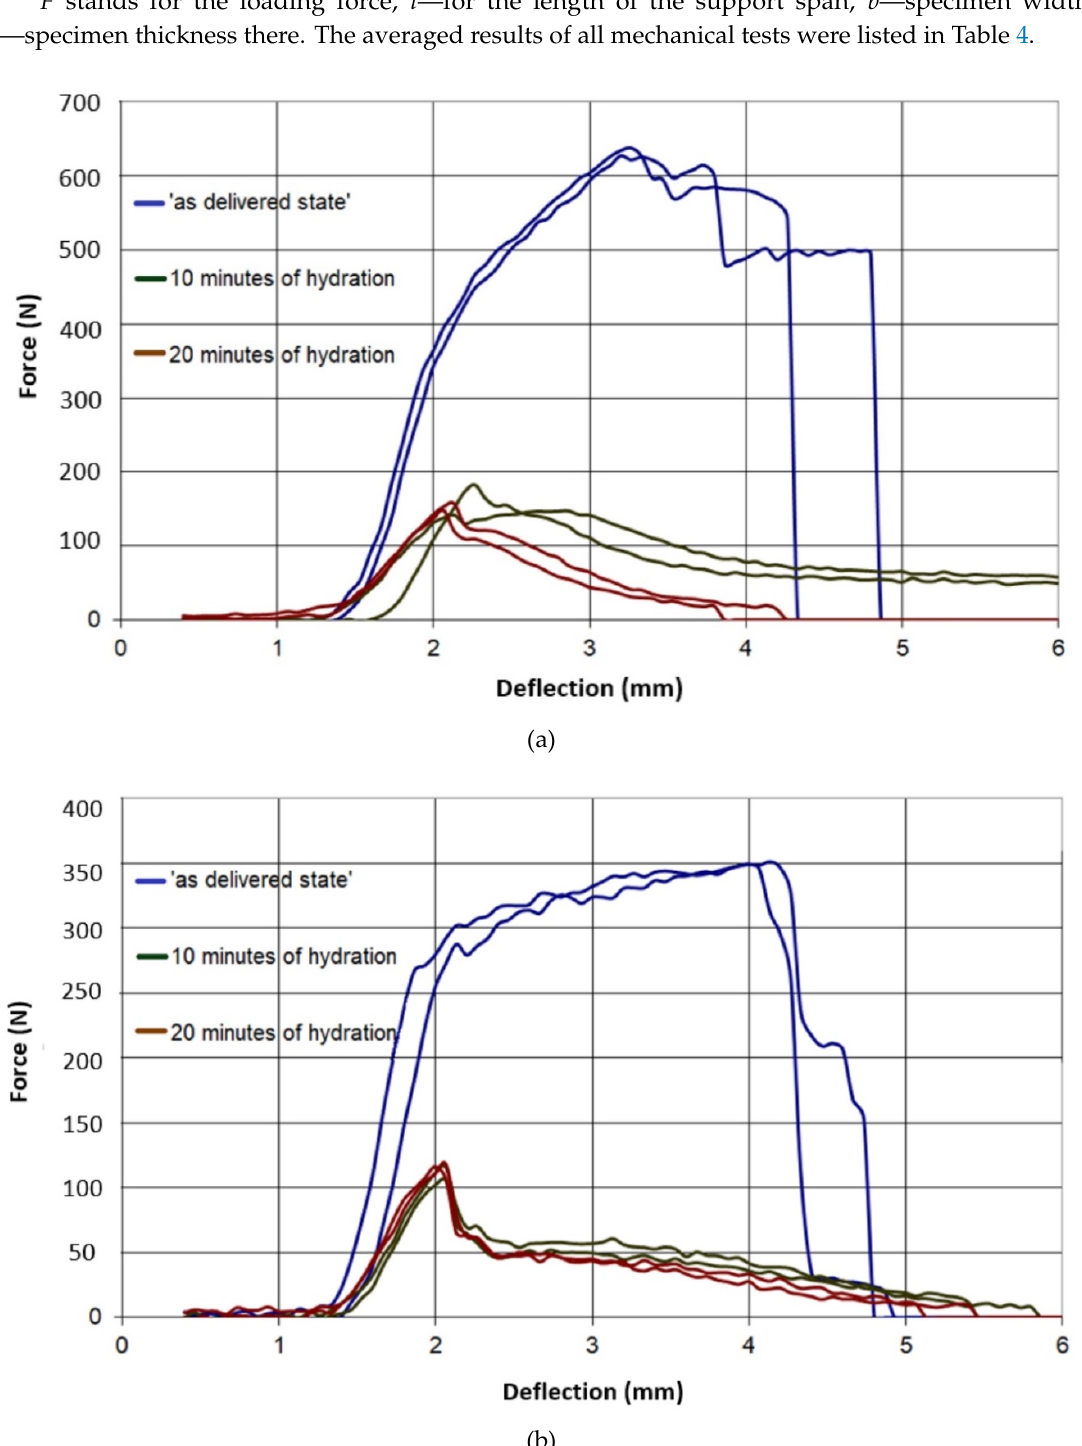
Figure 7. Force–deflection curves of the tested specimens of type A, ( a ) parallel to the sheet production direction, ( b ) perpendicular to sheet production